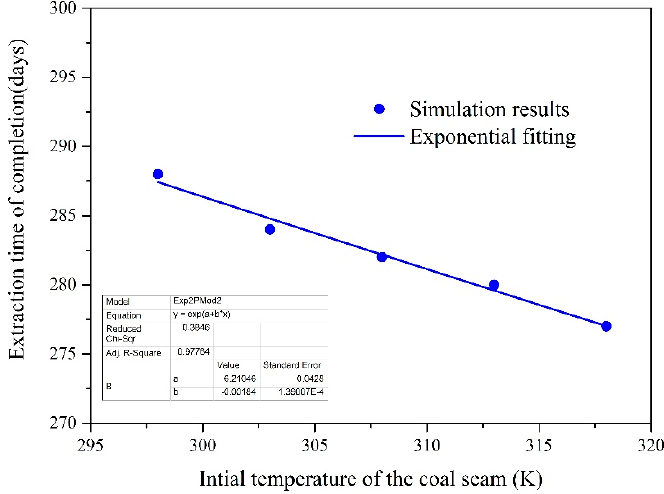
Figure 15. E ff ect of the initial temperature on extraction time of Figure 15. Effect of the initial temperature on extraction time of completion. Figure 15. Effect of the initial temperature on extraction time of completion.